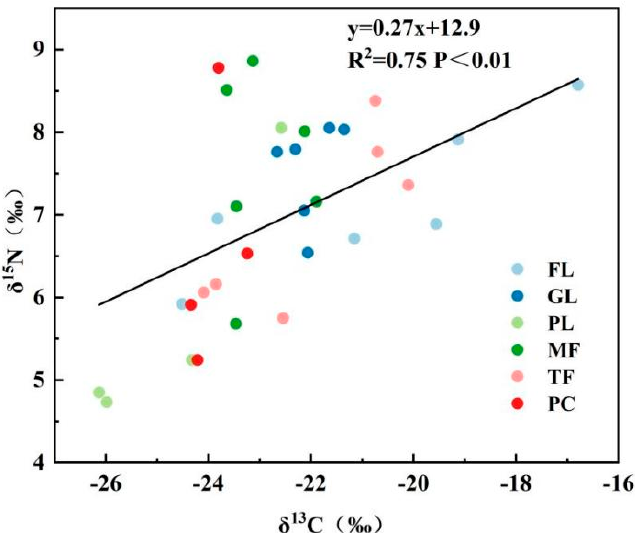
Figure 4 . Relationship between δ 13 C and δ 15 N values of 0–40 cm soils of six land use types in the dry season. In contrast, the linear relationship between δ 13 C and δ 15 N of soils in the rainy season is not credible ( P > 0.05), and therefore the best-fit curve between them is not shown.